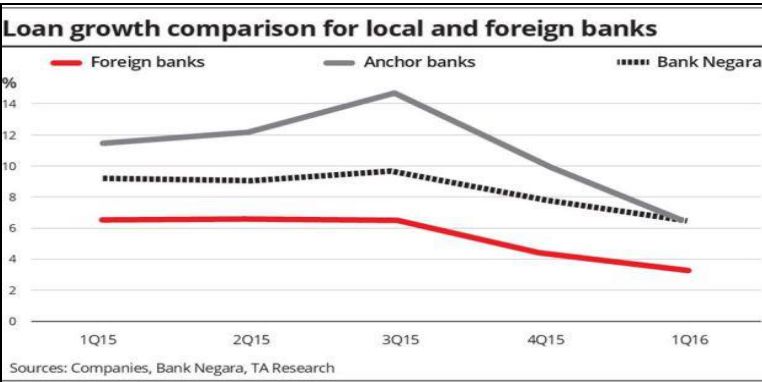
Figure 2: Foreign banks losing market share in Malaysia